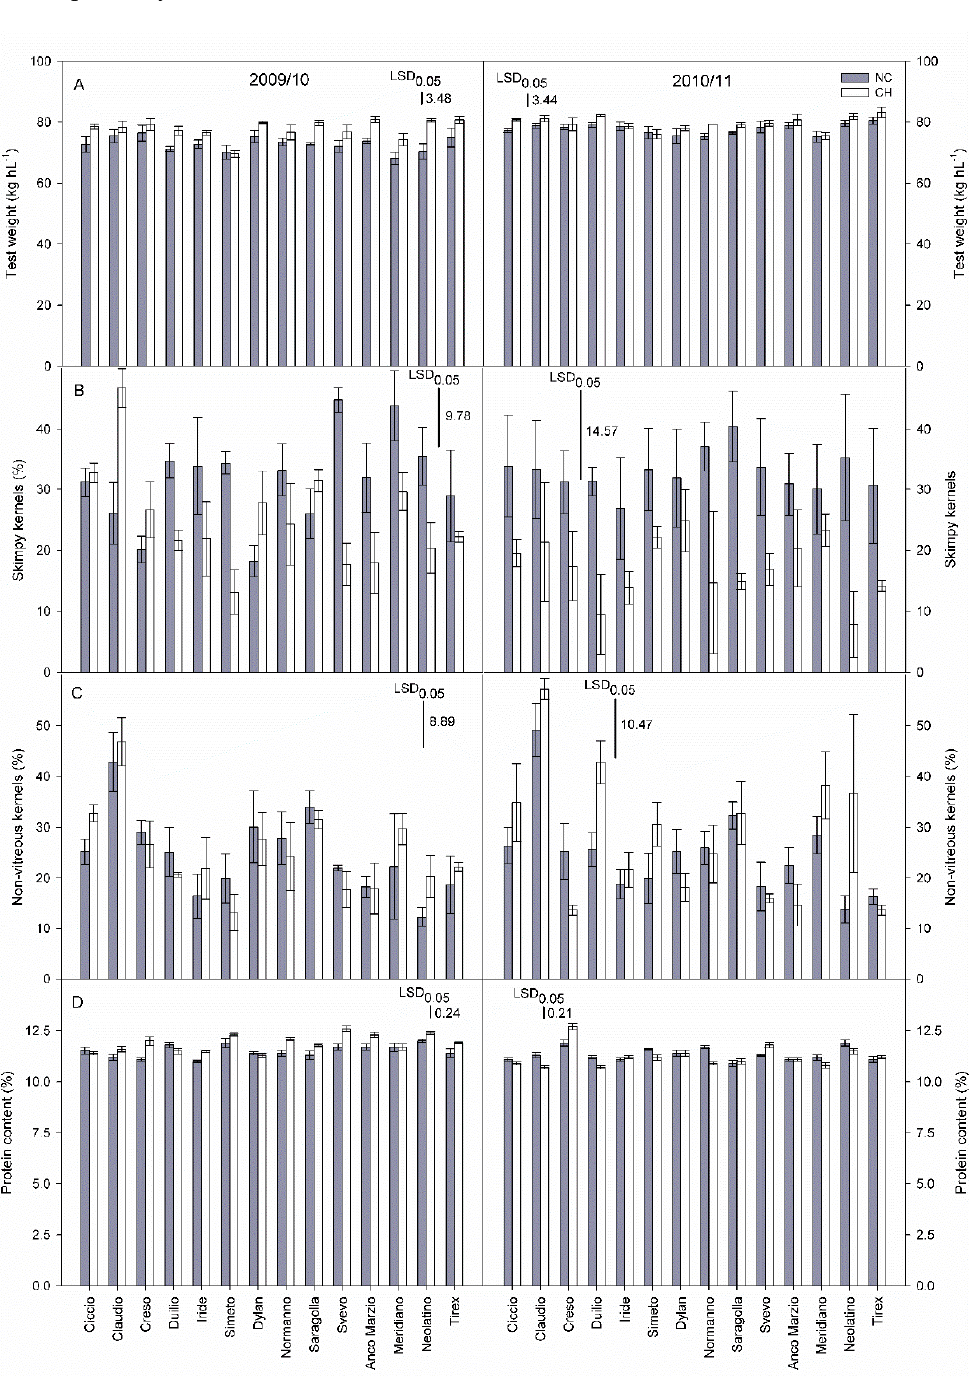
Figure 4. Quality traits of fourteen durum wheat genotypes under CH and NC in two growing seasons (2009 / 10 and 2010 / 11). ( A ) Test weight (Kg hL − 1 ); ( B ) Skimpy kernels (%); ( C ) Non-vilreous kernels (%); ( D ) Protein content (%). Vertical line “genotype × management system” interaction per p ≤ 0.05 (LSD 0.05 ).